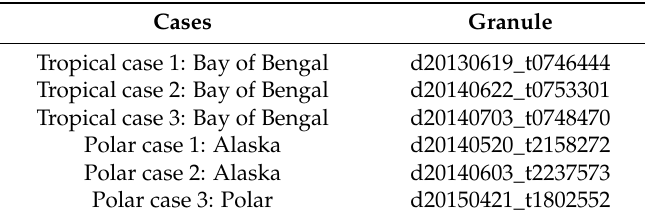
Table 2. Six cases used in this